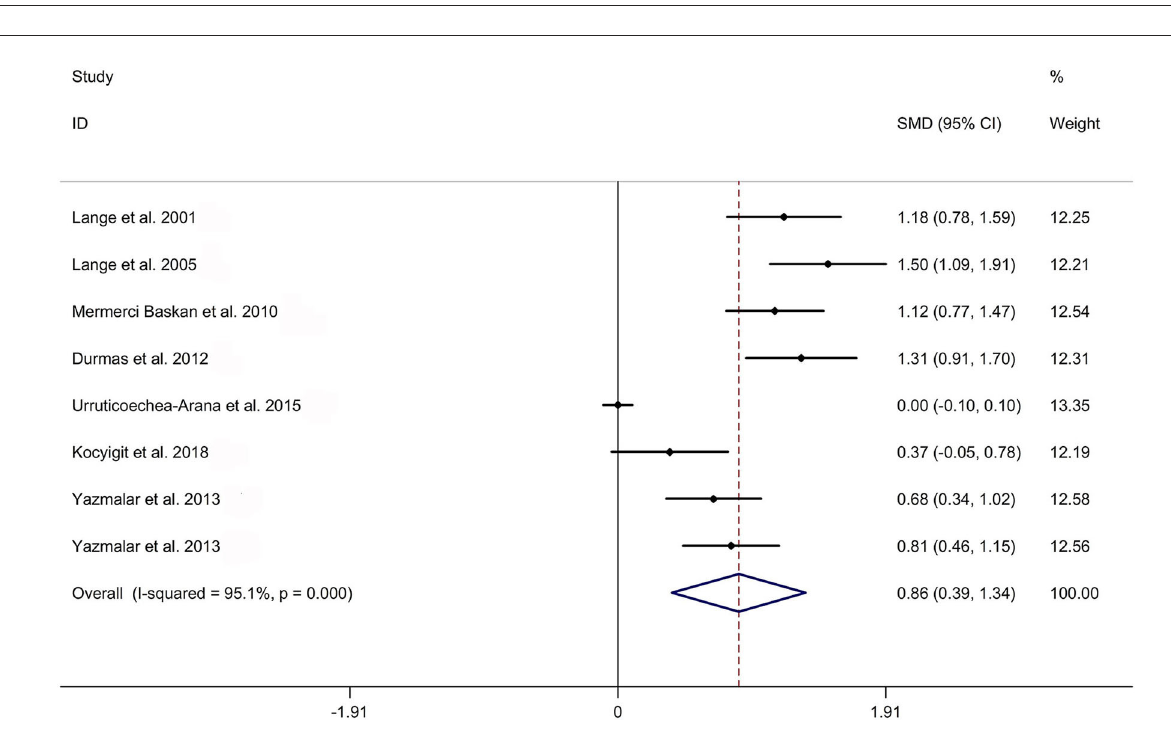
FIGURE6 Forest plot regarding comparison in peripheral PTH levels between AS and HC. AS, ankylosing spondylitis; HC, healthy controls; PTH, parathyroid